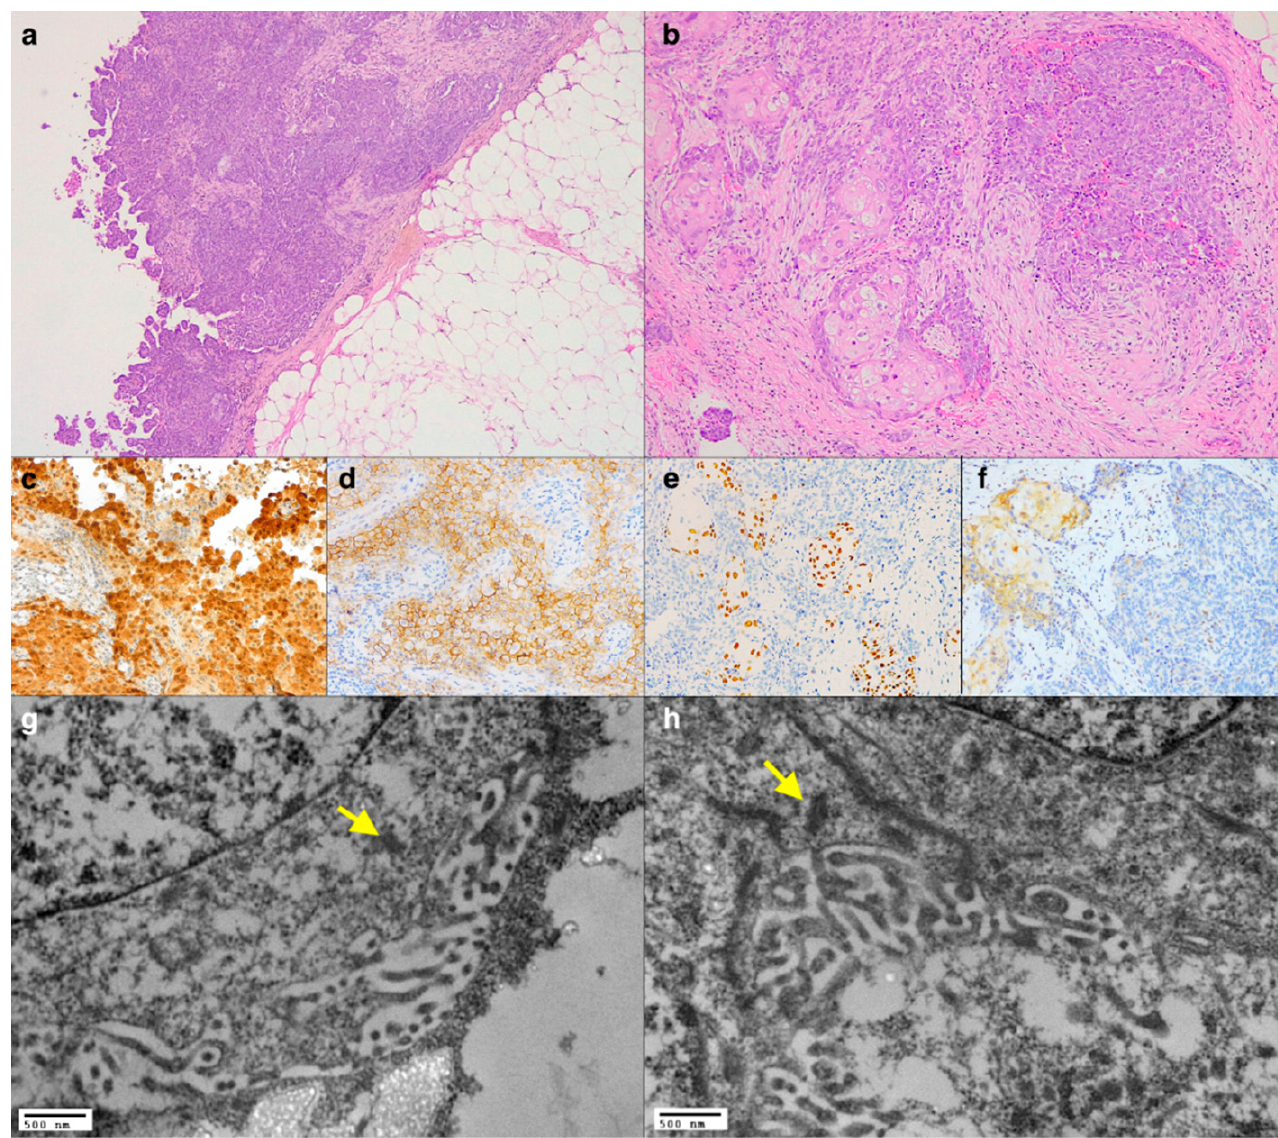
Figure 1. Panoramic view of the pleural tumour showing a prevalent solid pattern with papillary fronds ( a , haematoxylin and eosin stain, original magnification × 50), and several foci of squamous differentiation were evident at higher magnifi- cation ( b , haematoxylin and eosin stain, original magnification × 100). Immunohistochemistry showing the positivity of Calretinin ( c , immunoperoxidase staining, original magnification × 200), D2-40 ( d , immunoperoxidase staining, original magnification × 400), positivity of p40 in the squamous cells ( e , immunoperoxidase staining, original magnification × 200), and loss of nuclear expression of BAP1 in both the neoplastic components ( f , immunoperoxidase staining, original magni- fication × 200). TEM showing the presence of microvilli and tight junctions (yellow arrows) ( g , h , original magnification ×